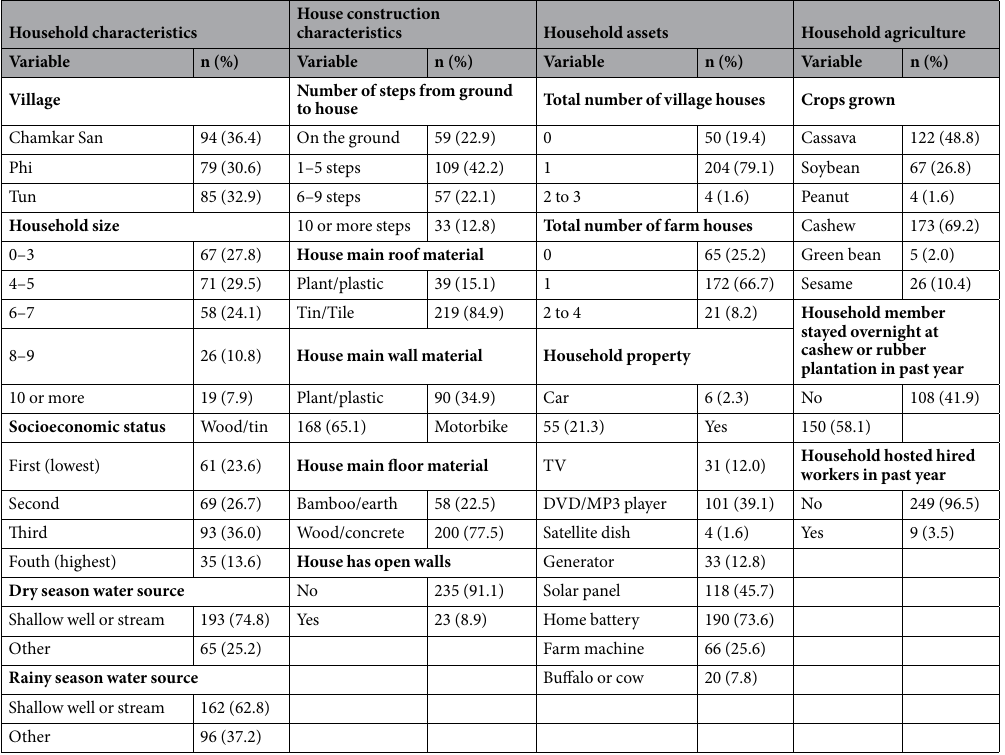
Table 5. Household-level characteristics of 258 households included in cross-sectional